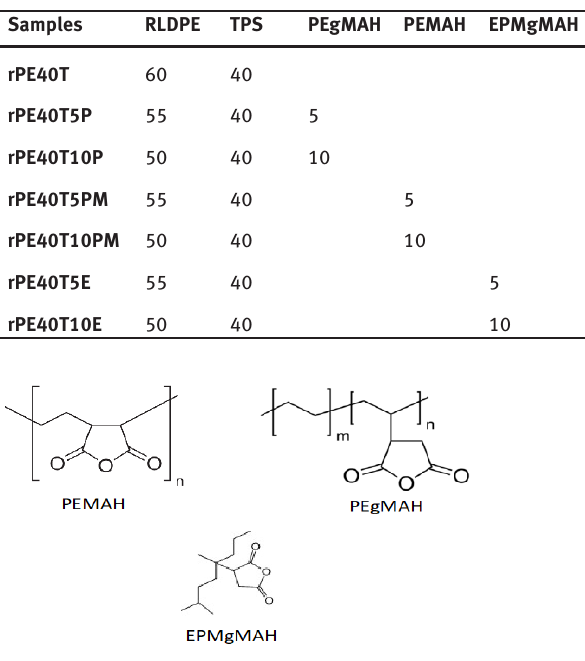
Figure 1: The chemical structure of the using